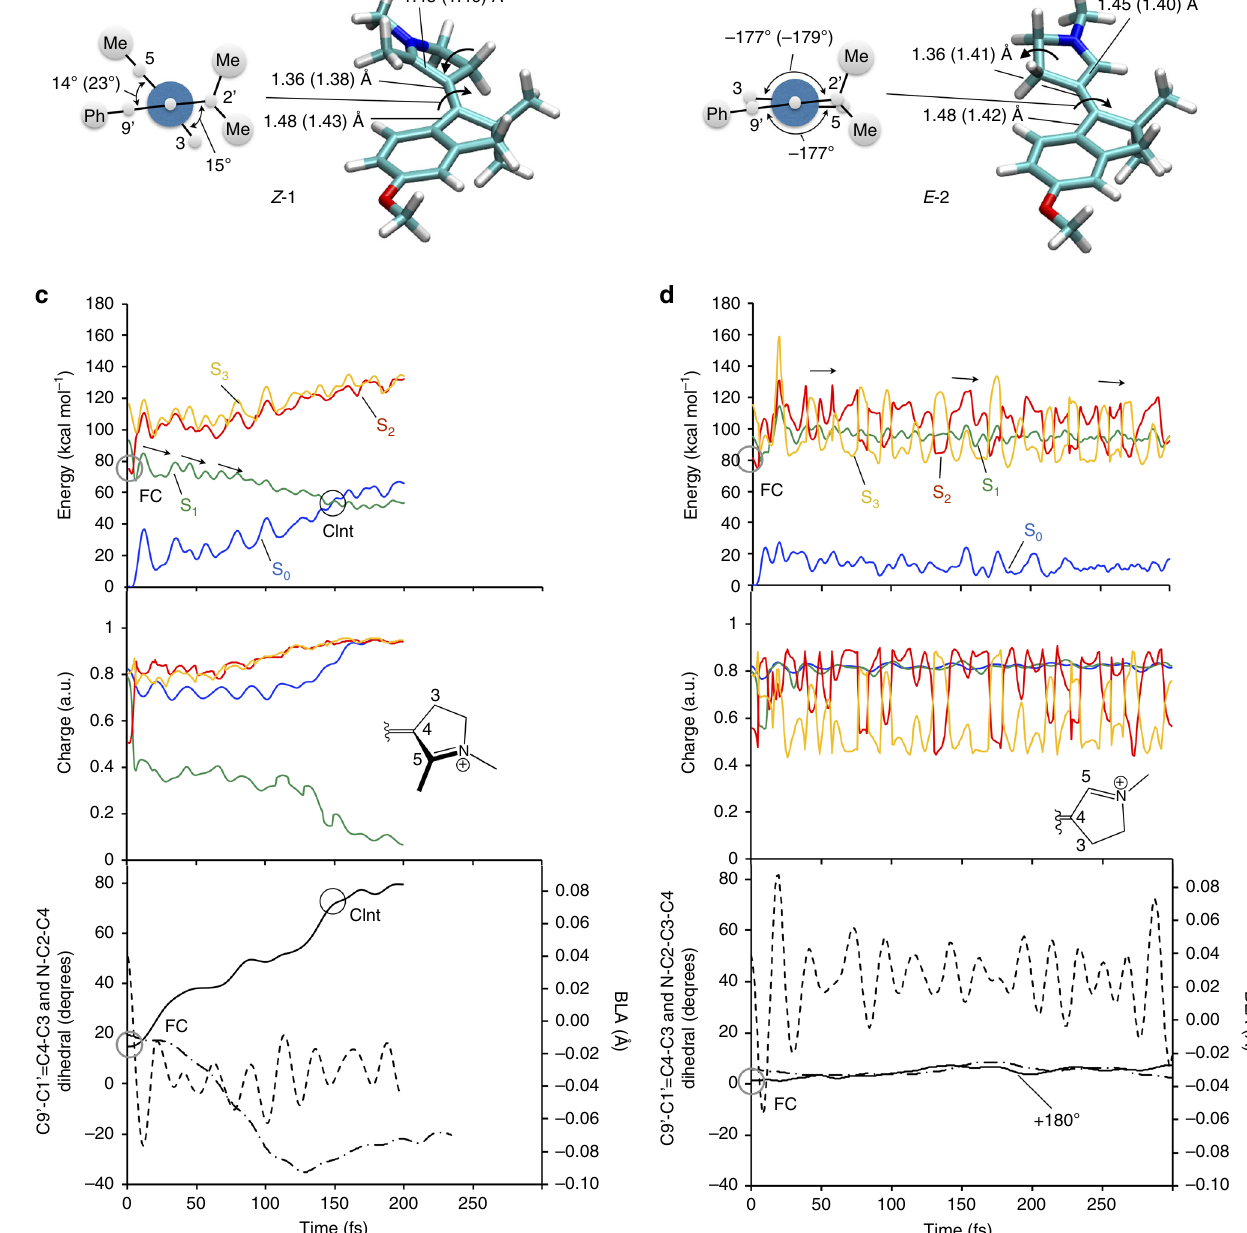
Fig. 4 Mechanistic interpretation of the in fl uence of the methyl substitution on C5. a , b Structure of the computed S 0 free energy minima of Z - 1 and E - 2 in methanol at room temperature and values of their relevant structural parameters. The values for the corresponding S 1 energy minima are given in parenthesis and the values of the C9 ʹ – C1 ʹ = C4 – C3 and C2 ʹ – C1 ʹ = C4 – C3 torsional parameters are given in the Newman projections on the left. A comparison with the available observed crystallographic parameters is given in Supplementary Fig. 2. c , d Computed S 1 trajectories of Z - 1 and E - 2 , respectively, in methanol solution, illustrated by (top panels) the S 0 , S 1 , and S 2 CASPT2//CASSCF/6-31G*/Amber energy pro fi les, (middle panels) the changes in electronic structure along the trajectories in terms of the fractional positive charge remaining on the pyrroline moiety of the switch, and (bottom panels) the progression along the reaction coordinate described through skeletal double-bond stretching (BLA, dashed line), out-of-plane deformation of the pyrroline ring (re fl ected by the = N – C2 – C3 – C4- dihedral, dashed-dotted line), double-bond twisting (C9 ʹ – C1 ′ = C4 – C3, full line). FC indicates the con fi gurations of a and b . CInt indicates a conical intersection point. Notice the slow progression of E- 2 along both twisting and out-of-plane deformation